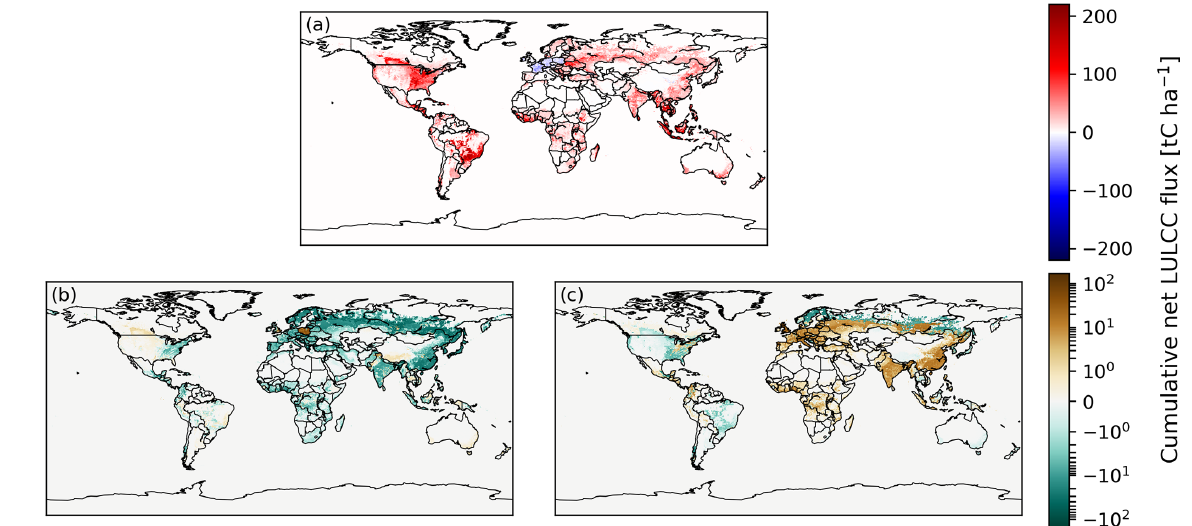
Figure 5. Cumulative net LULCC flux for the period 1850–2014 from REG1700 (a) as well as the difference HI1700 – REG1700 (b) and LO1700 – REG1700 (c) .